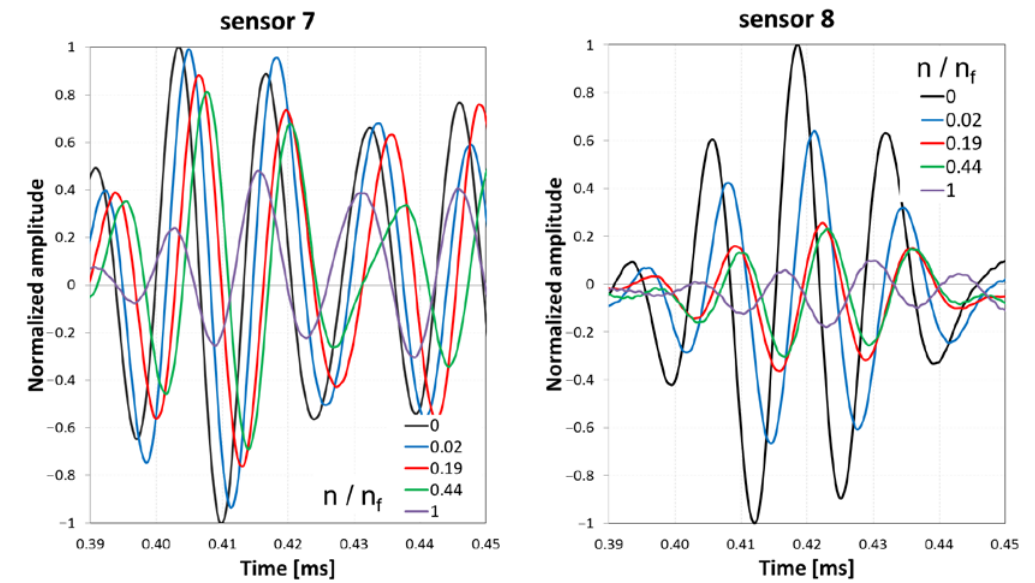
Figure 9. The signal responses at various stages of the fatigue damage (the sensor numbers are explained below in Figure 10).